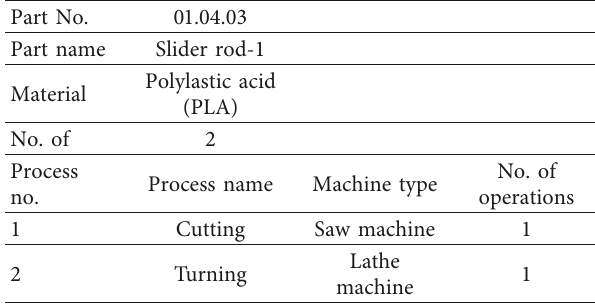
Table 13: Slider rod.